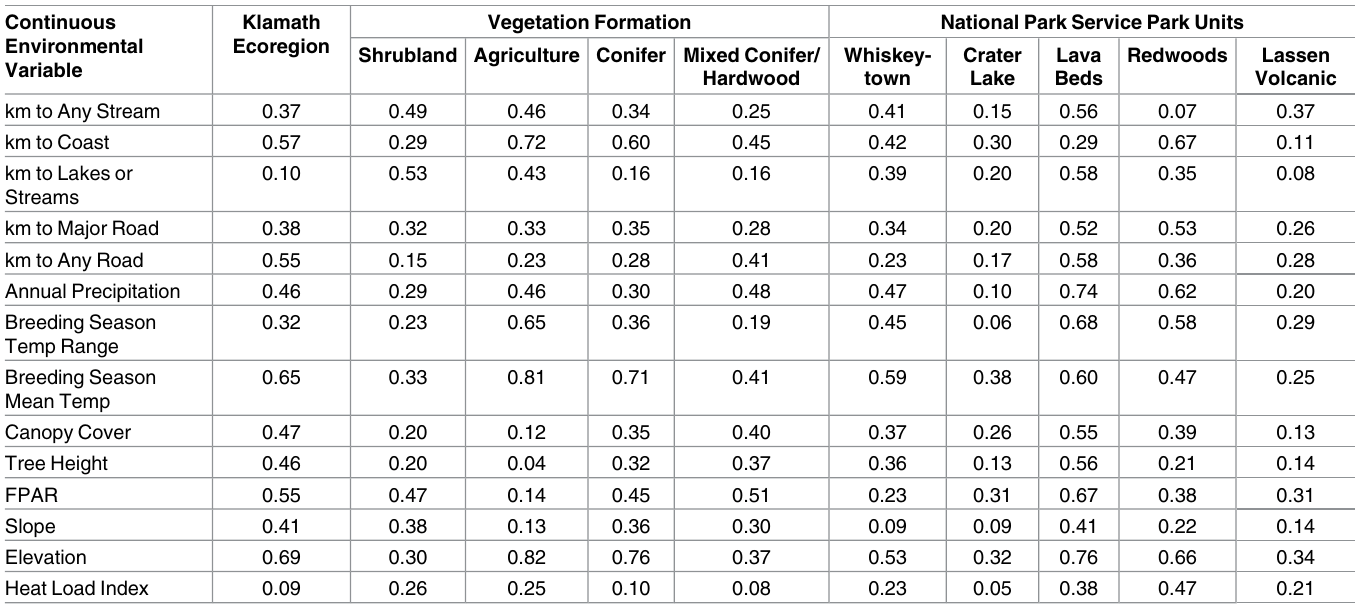
Table 3. Correlation Coefficients for Continuous Environmental Variables.